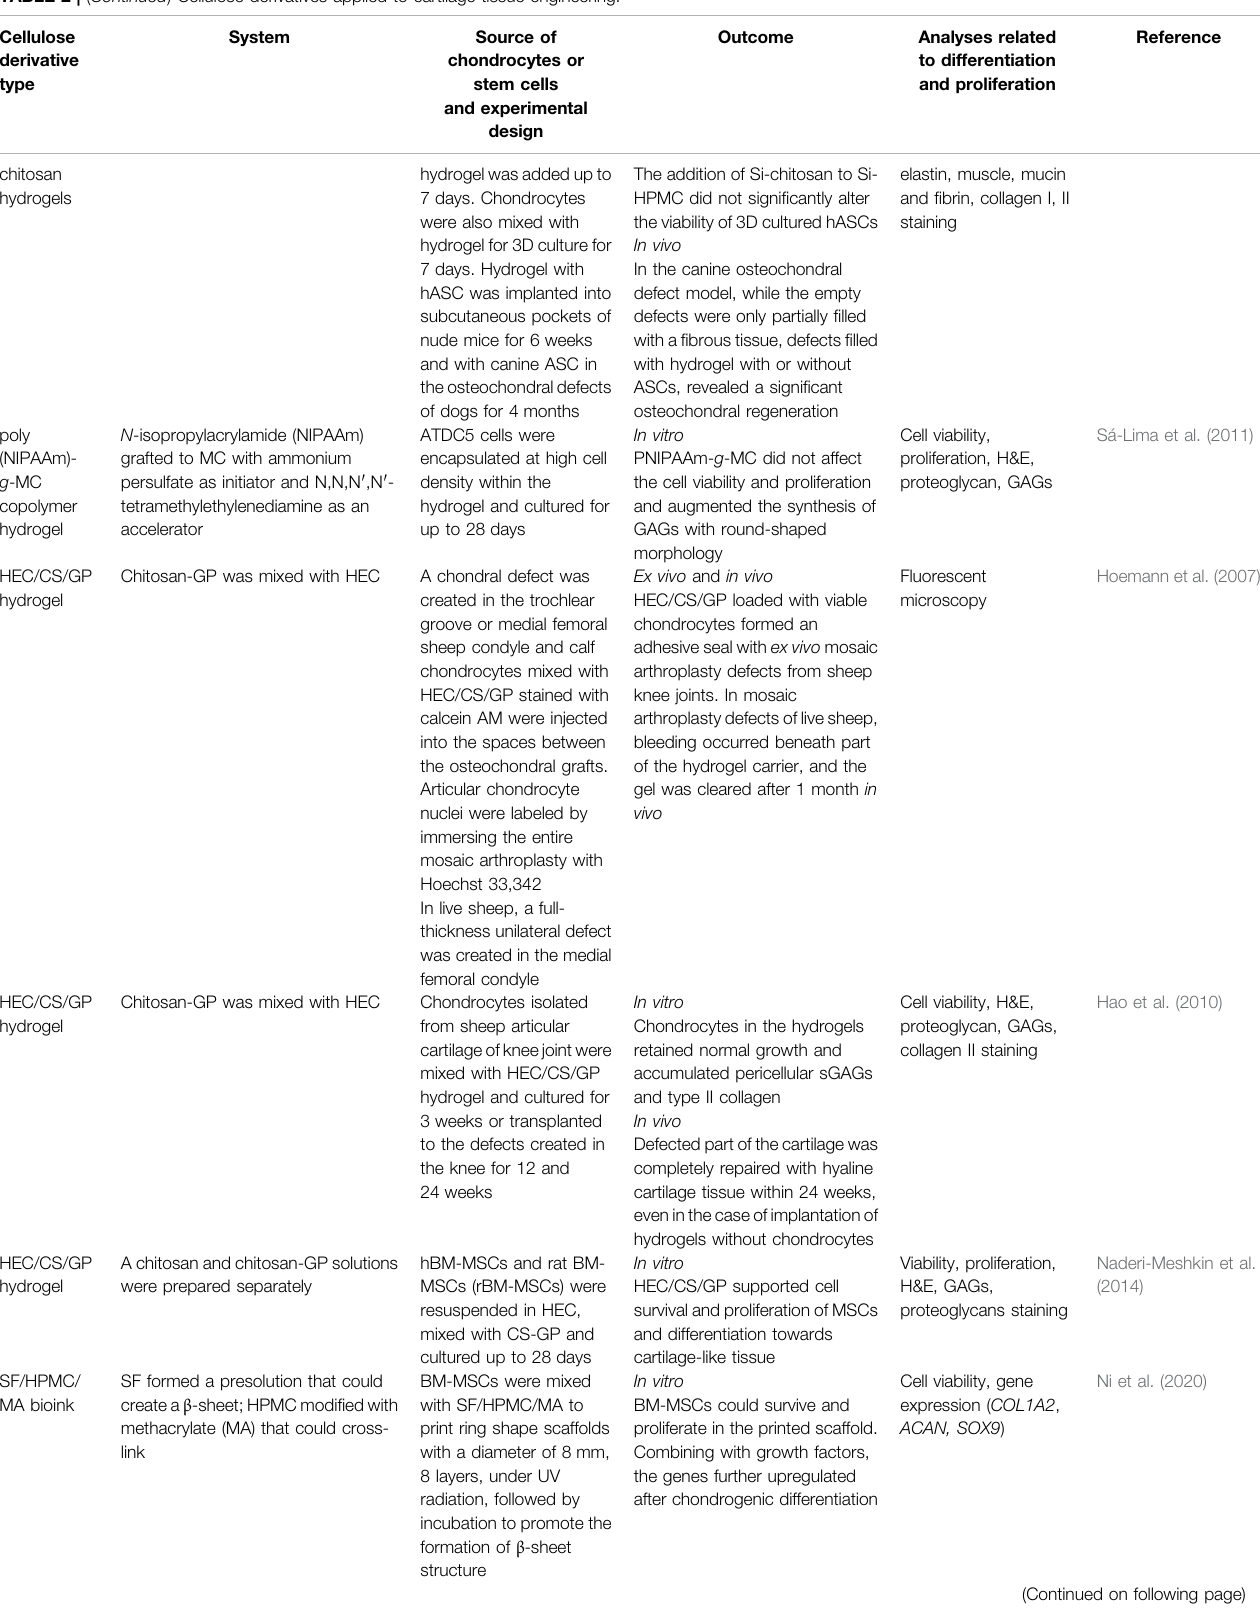
TABLE 2 | ( Continued ) Cellulose derivatives applied to cartilage tissue